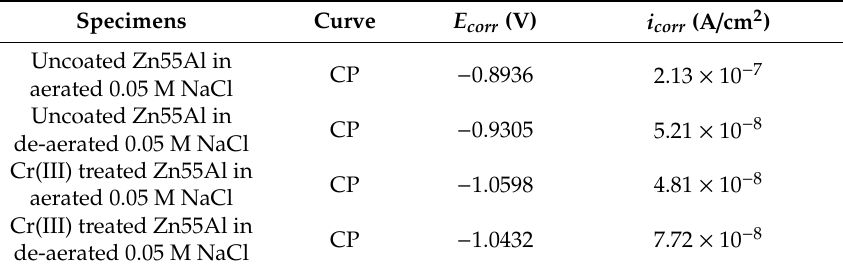
Table 2. Fitting results of cathodic polarization curves recorded in Figure 17.